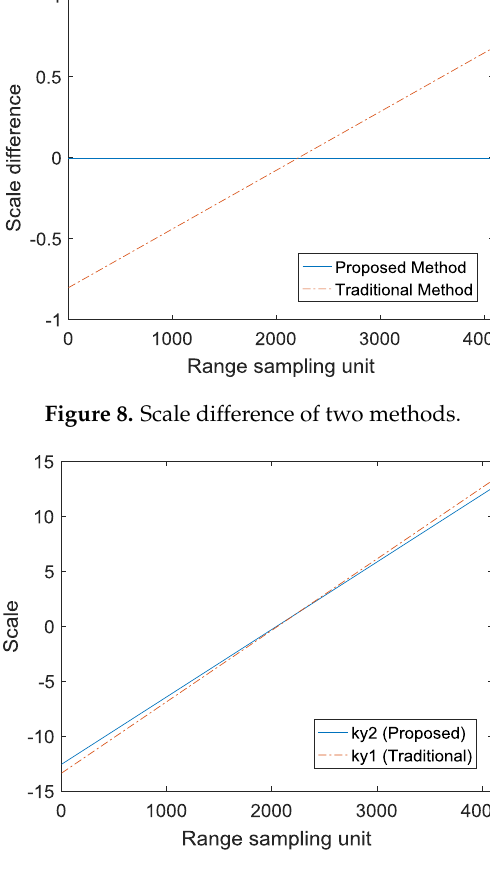
Figure 9. Comparison of two sampling methods.